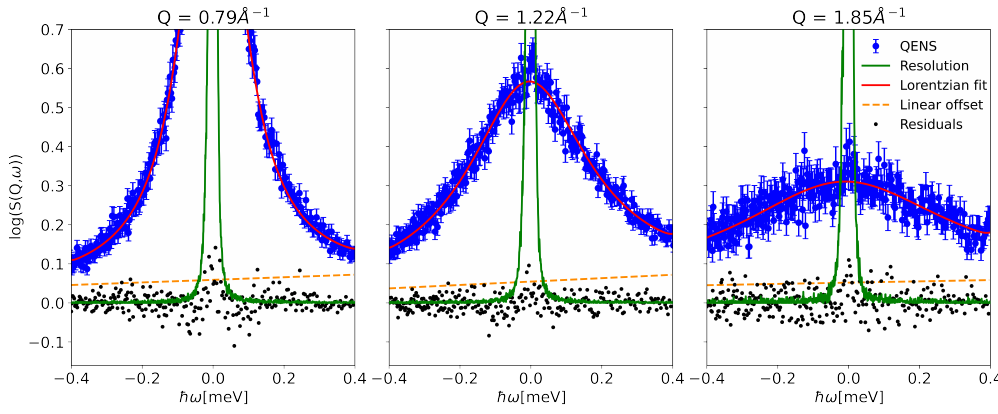
Figure 3. Zoom of the QENS experimental spectra for bulk-water at 300 K fitted using the jump di ff usion model (JDM), according to Eq. 10 at three di ff erent Q-values. The residuals between the Lorentzian fit and the QENS spectrum are also plotted along with the resolution and the linear background.